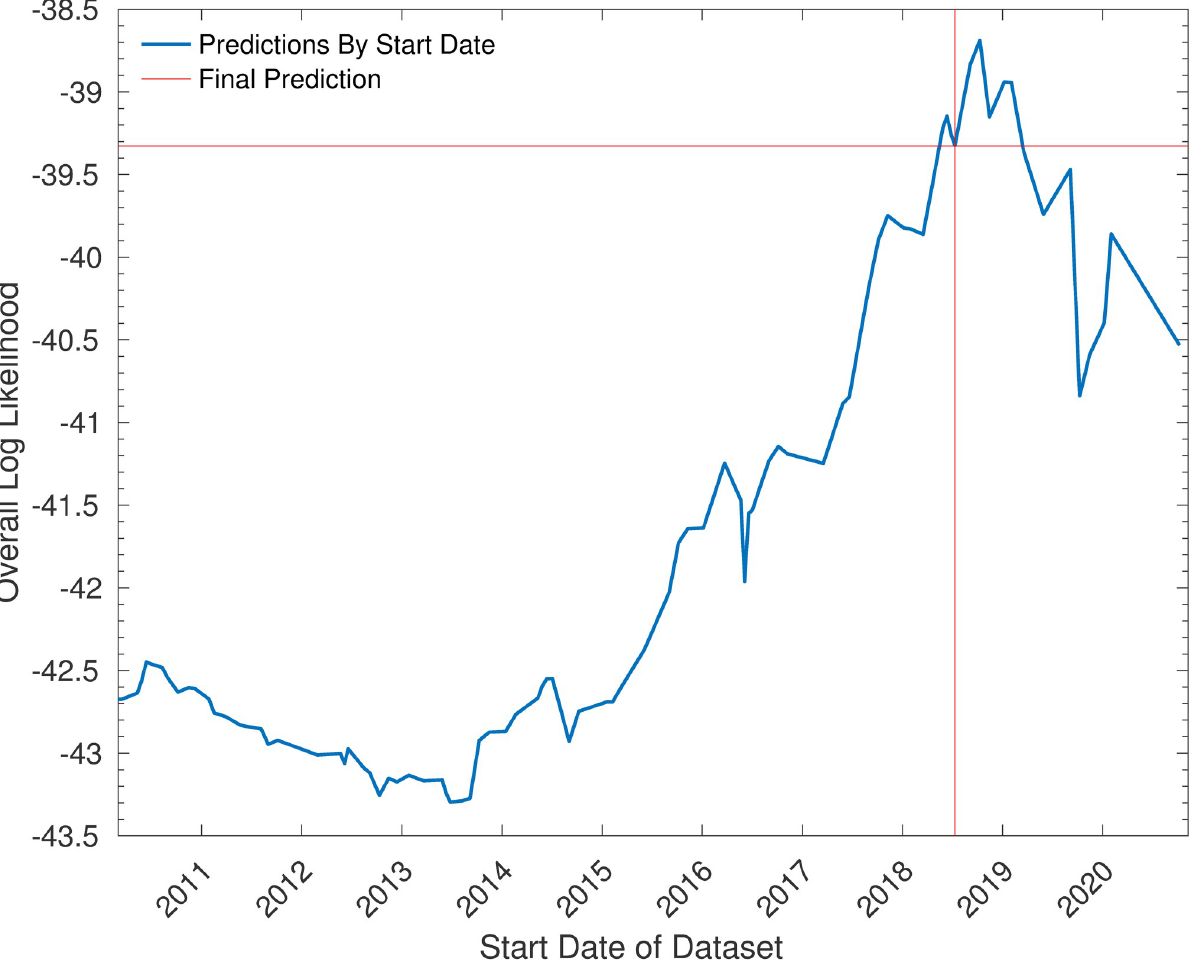
Fig 12. The log-likelihood of Euro 2020 as a function of the start date of the dataset used. This shows how the log-likelihood of Euro 2020 according to the model (the metric for the RSS competition) depends on the start date of the dataset of matches. Note that in all cases the end date was May 28, 2021—the date of submission to the competition, and each international break was considered as a single unit (and thus it was assumed that one would not set the start date in the middle of such a